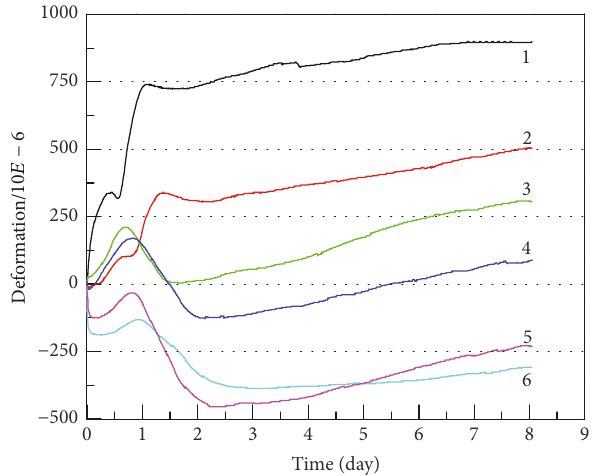
Figure 7: The initial setting time of pastes.